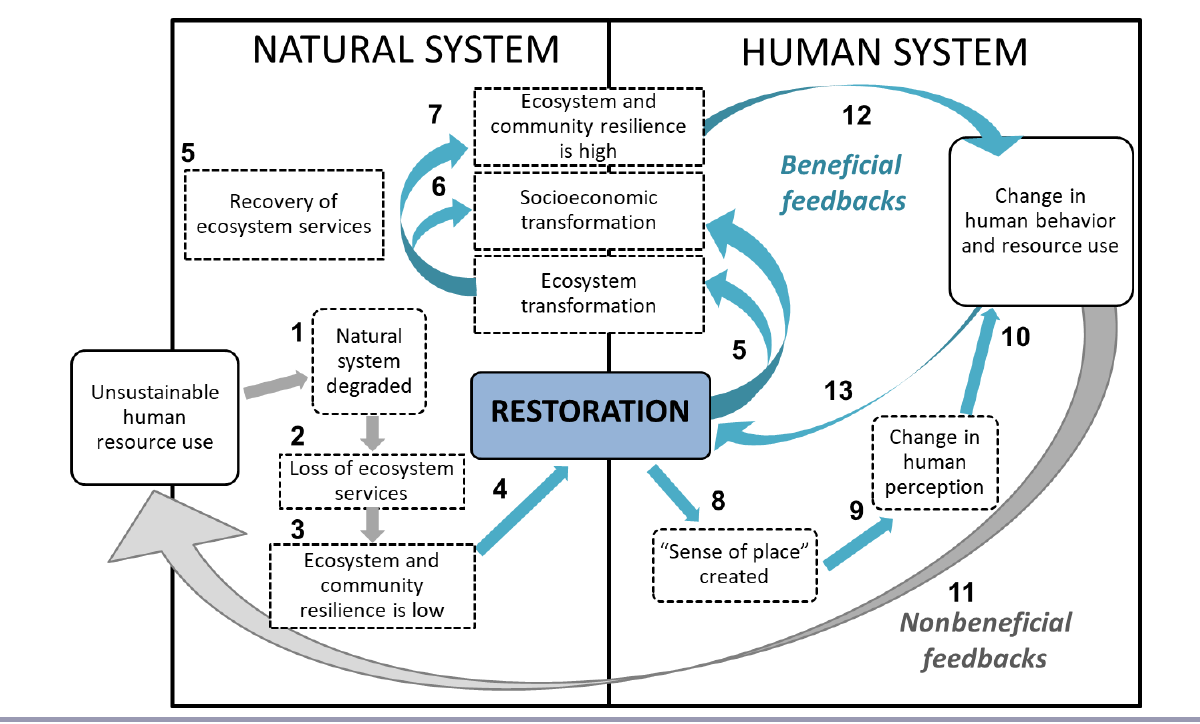
Fig. 2 . Feedbacks between human and natural systems, with restoration as a focal point. Solid boxes are actions, dashed boxes outcomes, and thick solid boxes outline the social and ecological components of general conceptual model from Figure